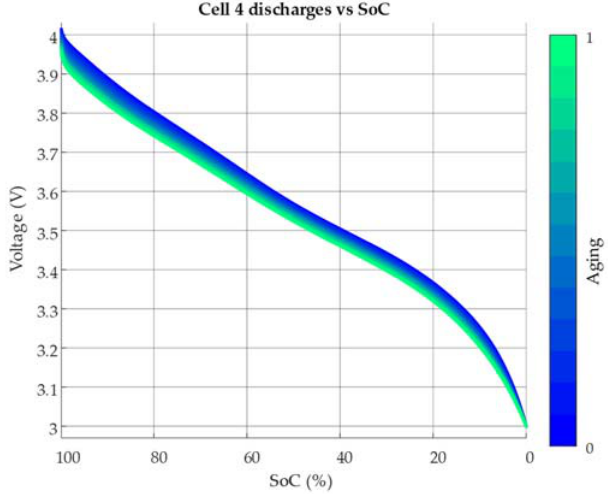
Figure 7. Voltage vs. SoC curves evolution with aging for cell 4.